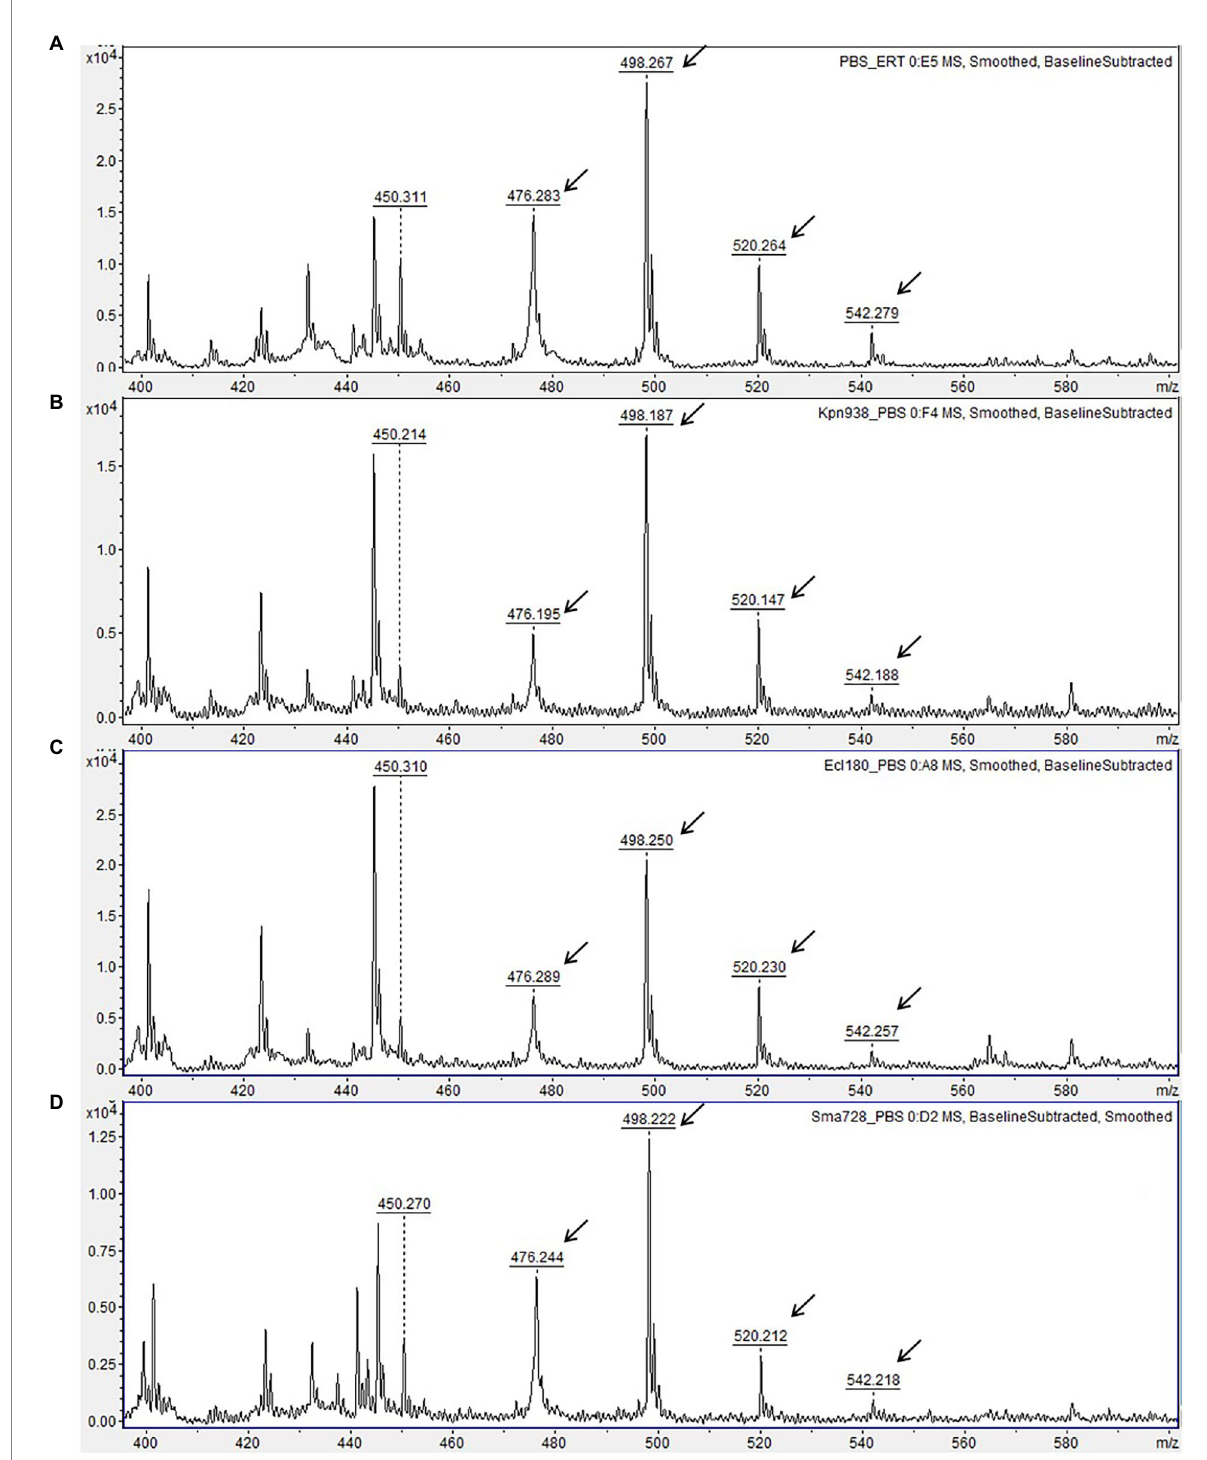
FIGURE 2 Matrix-assisted laser desorption ionization time-of-flight (MALDI-TOF) mass spectra of carbapenemase-non-producing isolates. (A) Mass spectrum of ertapenem disk after 3 h-incubation in 0.01 M PBS, pH 7.4 (negative control). (B–D) Mass spectra of ertapenem after incubation with carbapenemase-non-producing isolates of different species. Peaks corresponding to non-hydrolyzed form of ertapenem are indicated with arrows. Units on the Y axes represent relative